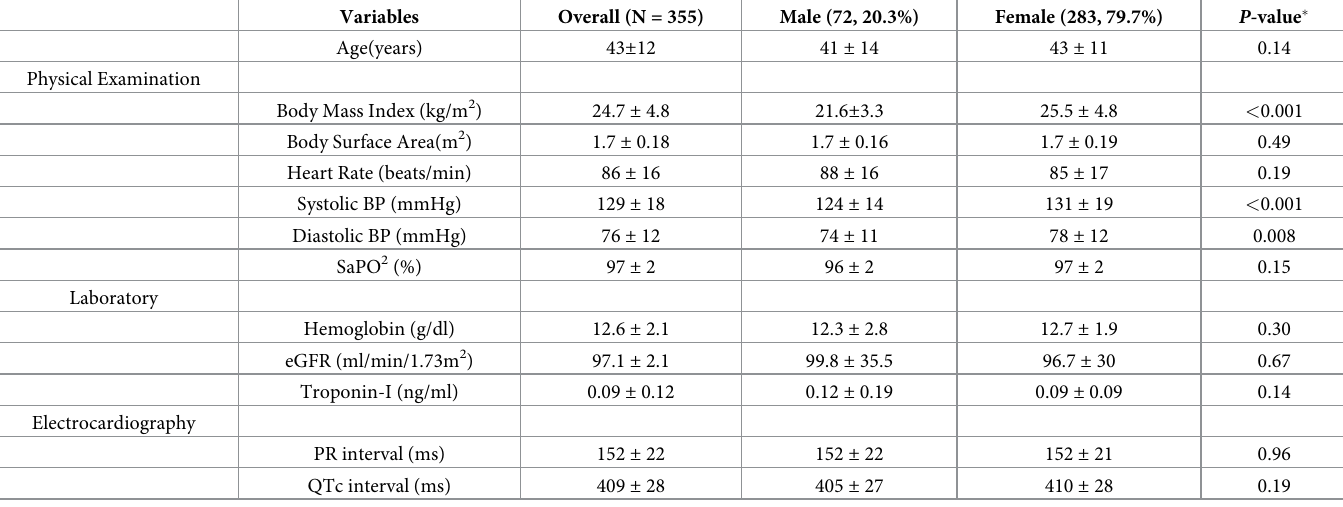
Table 1. Patient characteristics, laboratory and ECG